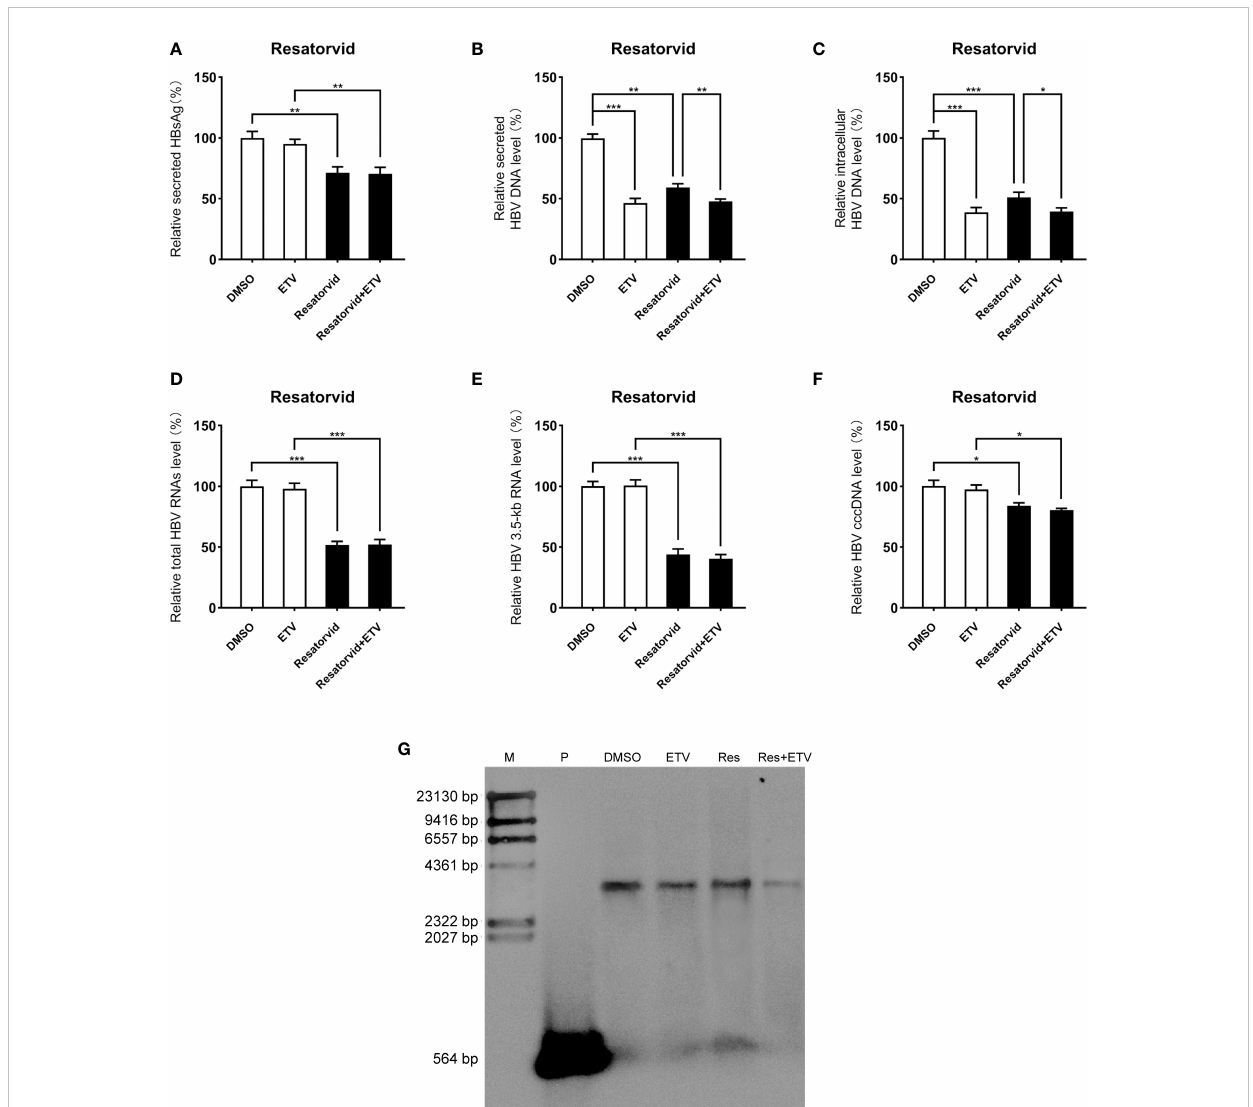
FIGURE 7 Resatorvid showed anti-HBV activity in the HBV infection model. The HBV-infected cells were treated with 0.1% DMSO, 0.5 nM resatorvid or/and 25 nM ETV for 10 days. (A) The results of the ELISA showed that resatorvid decreased the HBsAg level in the supernatant. (B-E) Resatorvid signi fi cantly inhibited secreted and intracellular HBV DNA, total HBV RNAs, and the 3.5-kb RNA. (F) Resatorvid partly decreased the level of cccDNA. (G) A Southern blot analysis was performed to determine the reduction of HBV DNA. *, P < 0.05; **, P < 0.01; ***, P <